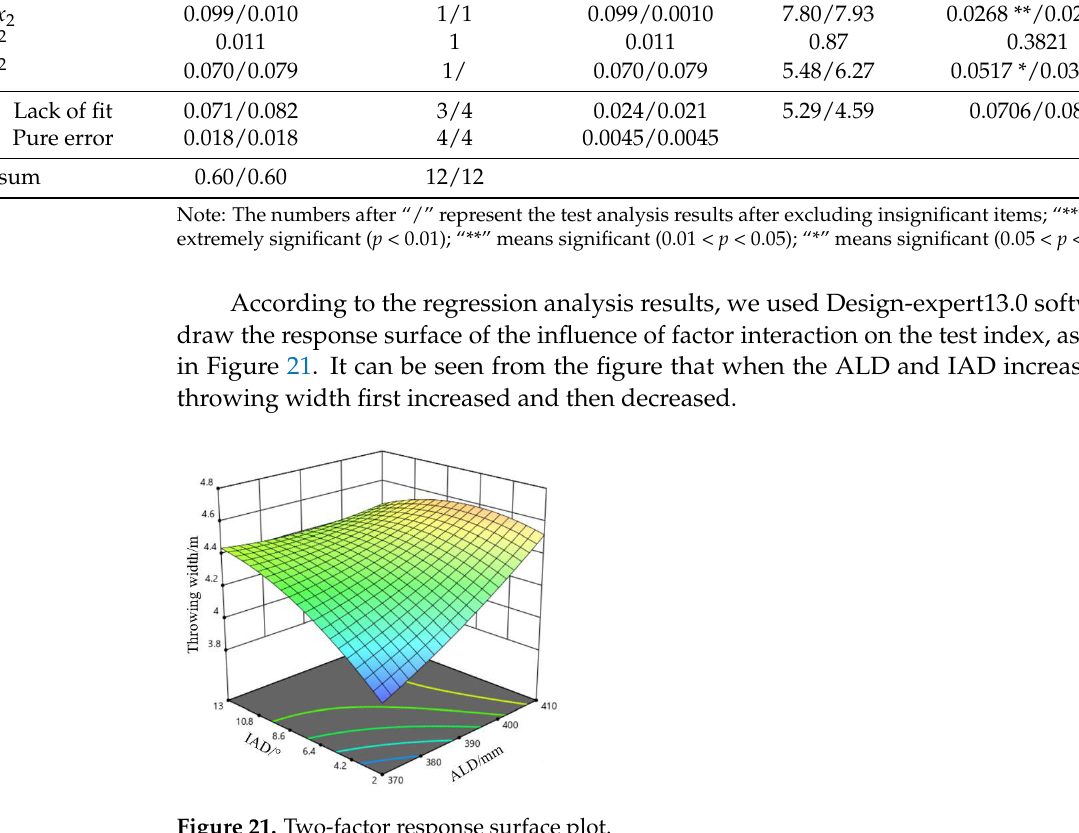
Figure 21. Two-factor response surface plot.